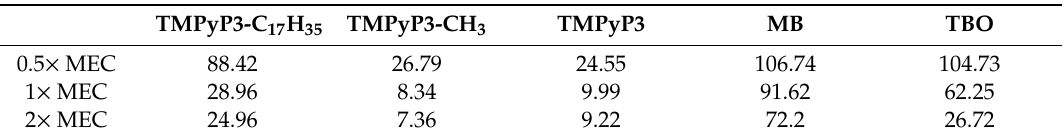
Table 4. Light dose for 50% inhibition (J / cm 2 ) of Legionella using PSs at 0.5 × MEC, 1 × MEC and 2 × MEC concentrations (MEC values are obtained for all PSs at 12 J / cm 2 and given in Table